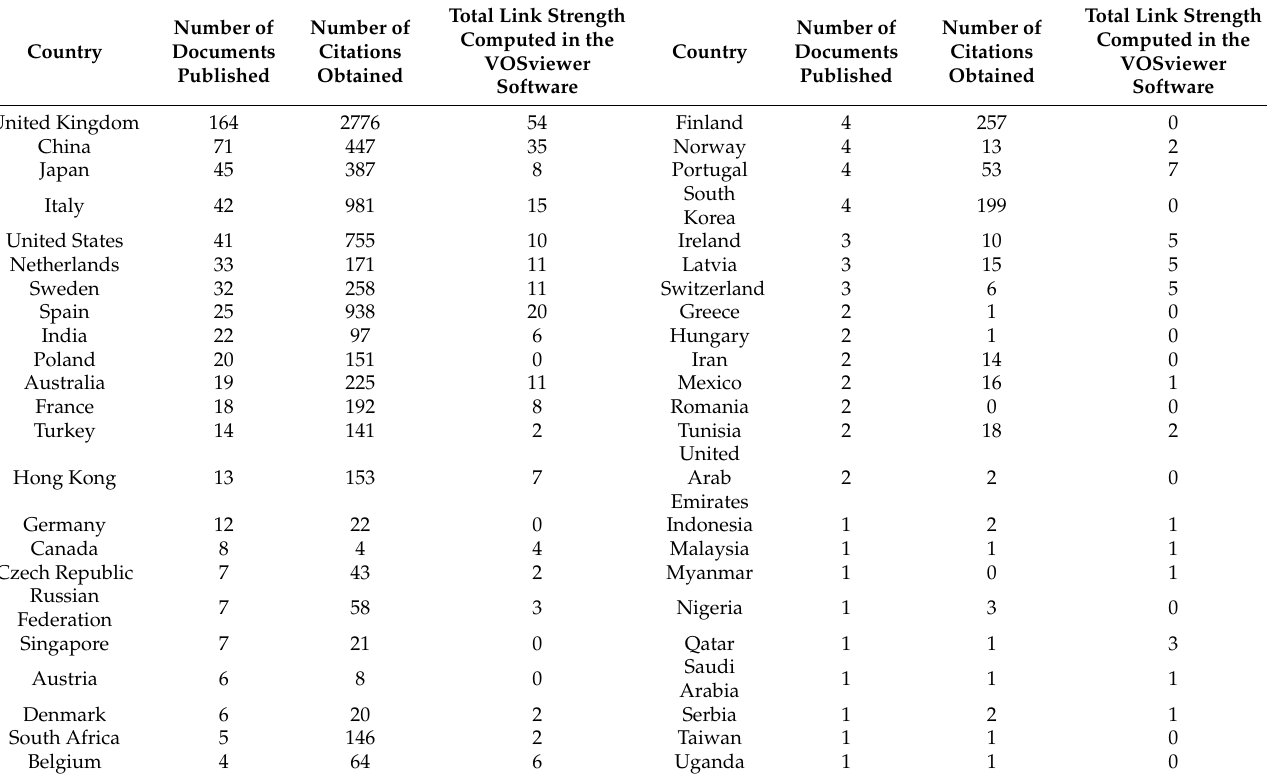
Table 3. Countries’ specific cooperation in the research on “condition monitoring”, obtained using VOSviewer software (version